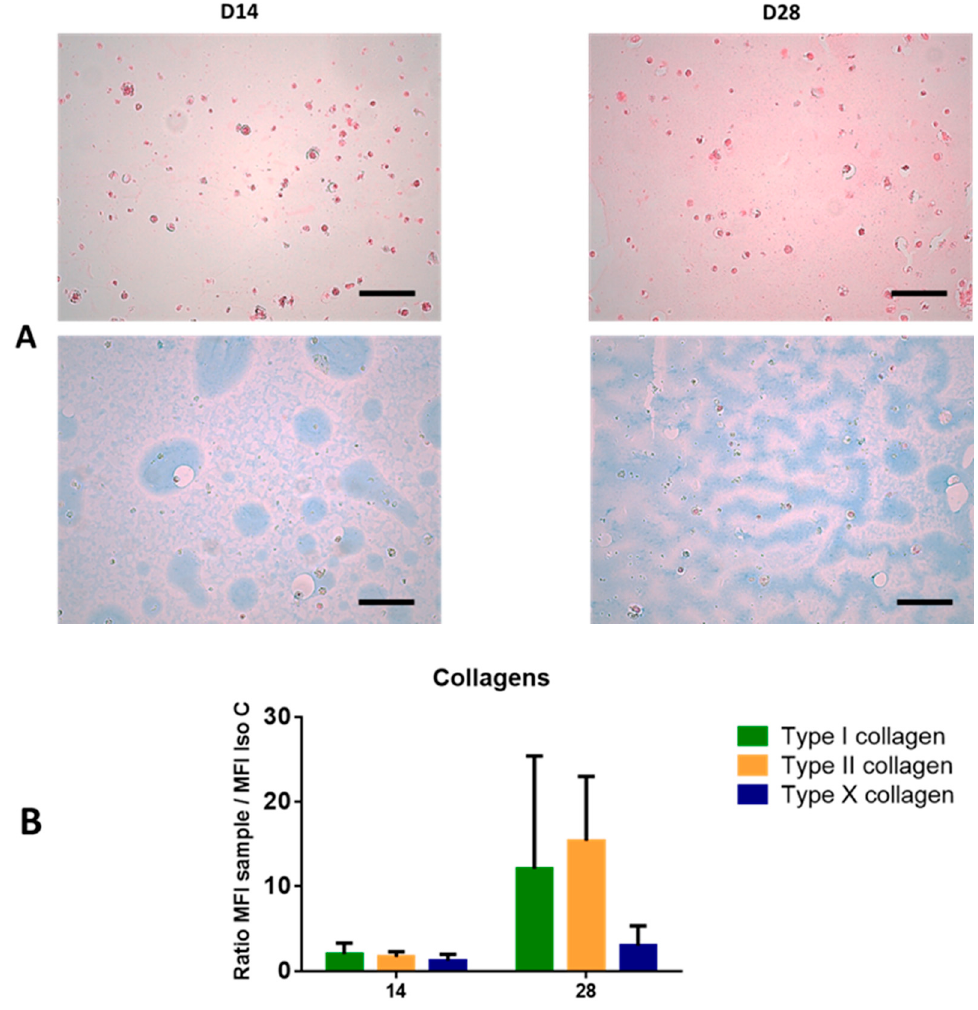
Figure 2. Chondogenic differentiation represented by matrix synthesis ( A ) and pericellular collagen expression ( B ). The synthetized matrix by chondro-MSCs seeded in alginate (Alg)/hyaluronic acid (HA) hydrogels was studied in histological sections ( A ) through the detection of collagen fibers (sirius red staining) and proteoglycans (alcian blue staining). Histological sections were obtained on Day 14 (D14) and Day 28 (D28) of chondrocyte differentiation. Scale bars correspond to 100 µm. Pericellular collagens (type I, II and X collagen) around chondro-MSCs were analyzed by flow cytometry in ratio of mean fluorescence intensity (MFI) of the sample compared with the isotype control (Iso C) ( B ) at different time points of cell culture (D14 and D28). Biomaterial dissolution was performed before indirect staining. Data are expressed as mean ± SD ( N = 3 independent cords). No statistically significant difference was observed.